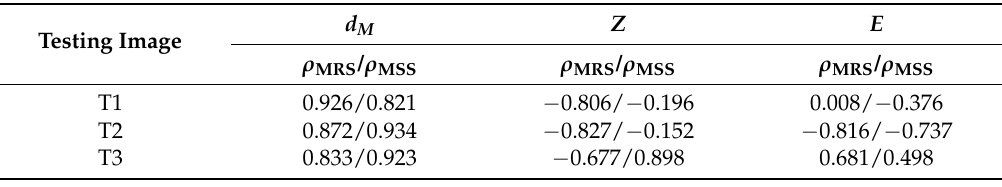
Table 5. The value of the Spearman’s rank correlation between each unsupervised method and the supervised method ARI . Respectively, ρ MRS and ρ MSS indicate the correlation coefficient ρ from the evaluation results for MRS and MSS.